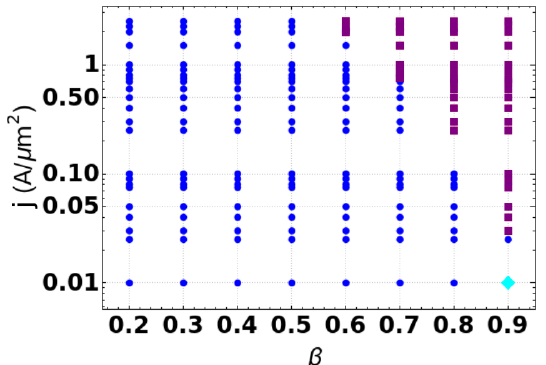
Figure 3. Diagram of the skyrmion’s dynamical behaviors as a function of β and J . The (blue) dots represent the state of a global oscillatory regime. The (purple) squares display the state of skyrmion annihilation. The (cyan) diamond depicts the state of a local oscillation.